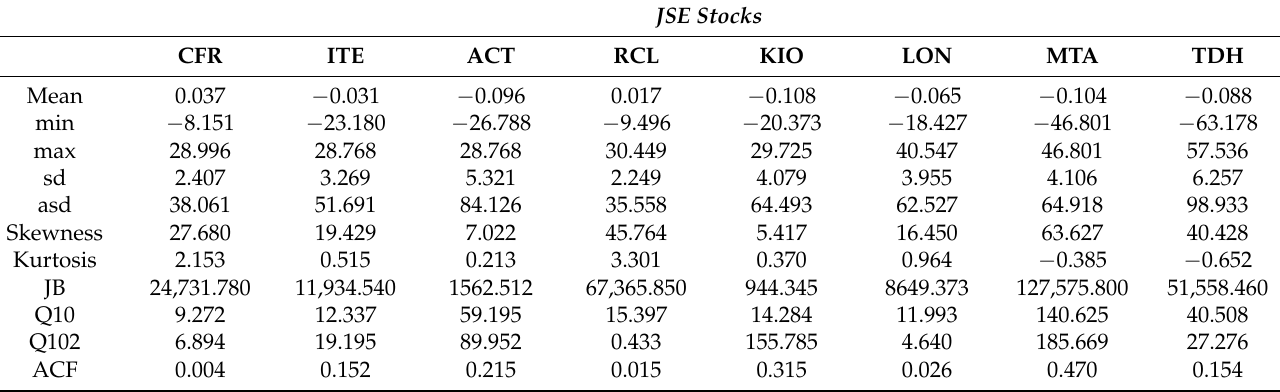
Table 2. Summary statistics of classified JSE stocks with higher behavioral